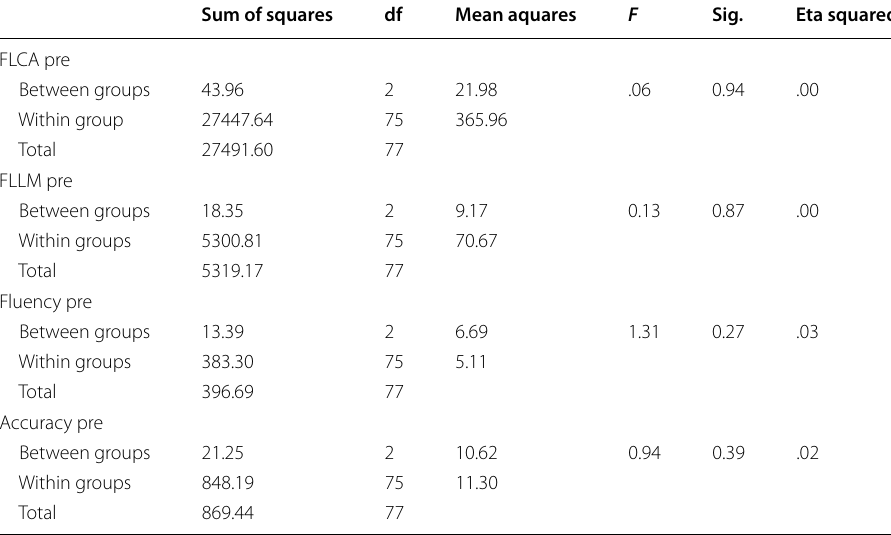
Table 2 Comparing CG, EG1, and EG2 mean scores on the pre-test of SAF, FLCA, and FLLM (one-way ANOVA) Sum of squares df Mean aquares F